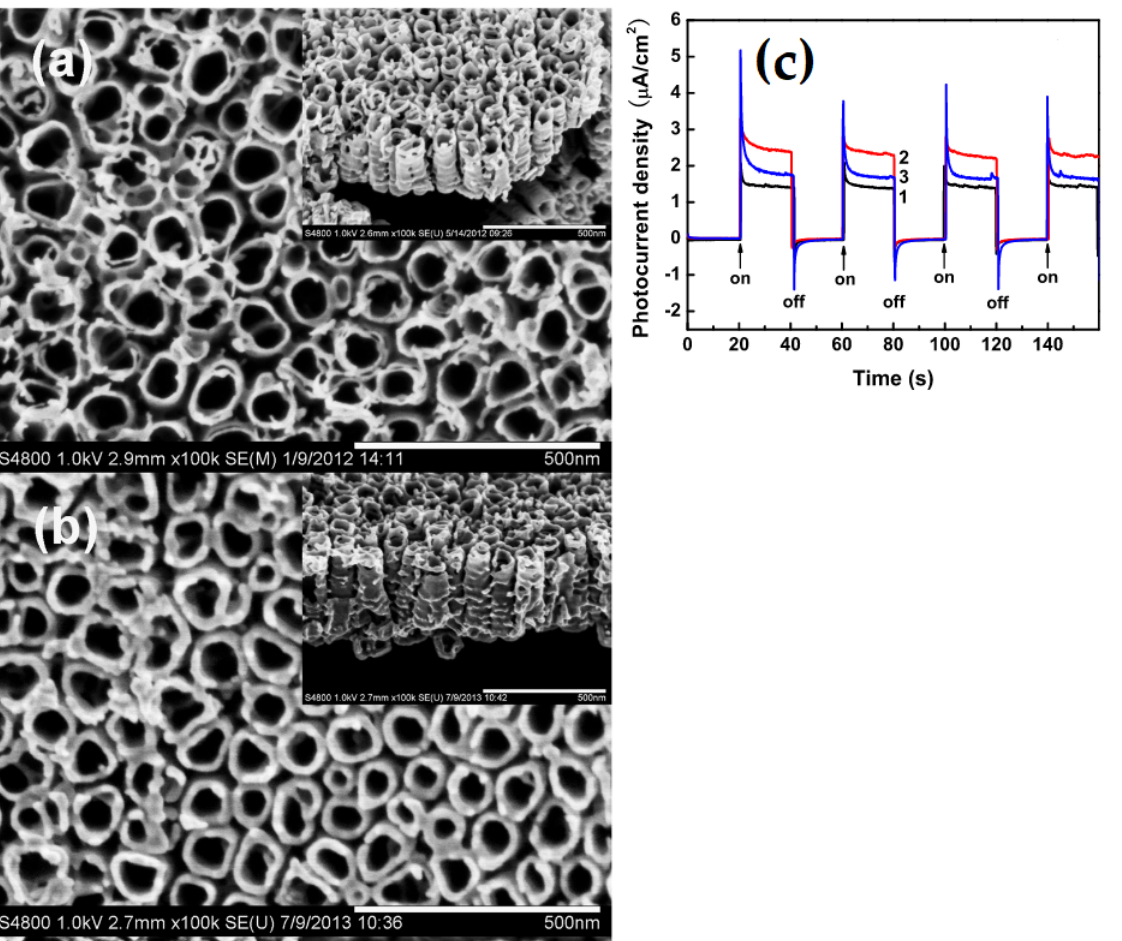
Figure 11. ( a , b ) Top view and cross-sectional pictures of bare TiO 2 NTs, 10-cycle ZnO/TiO 2 NTs, and 25-cycle ZnO/TiO 2 NTs with TiO 2 NTs having average diameters of around 60 nm and wall thicknesses of around 15 nm, respectively. ( b ) When illuminated by light with a 420 nm wavelength, compared to the bare TiO 2 -NTs, the ZnO-coated TiO 2 NTs exhibit increased photoelectrochemical activity. The 10-fold ZnO-coated TiO 2 NTs in particular show a notable increase in photoelectrochem- ical activity. According to PC density ( c ), the 10-fold ZnO/TiO 2 NT photoelectrode still exhibits rapid and excellent transient photocurrent responses under intermittent illumination after roughly 1.5 h of visible illumination with light of a 420 nm wavelength, as can be seen at PC densities transients of bare TiO2 NT (black line), 10-cycle ZnO/TiO2 NT (red line) and 25-cycle ZnO/TiO2 NT (blue line). Reprinted with permission from Ref. [71]. Copyright © 2023 BioMed Central Ltd.,